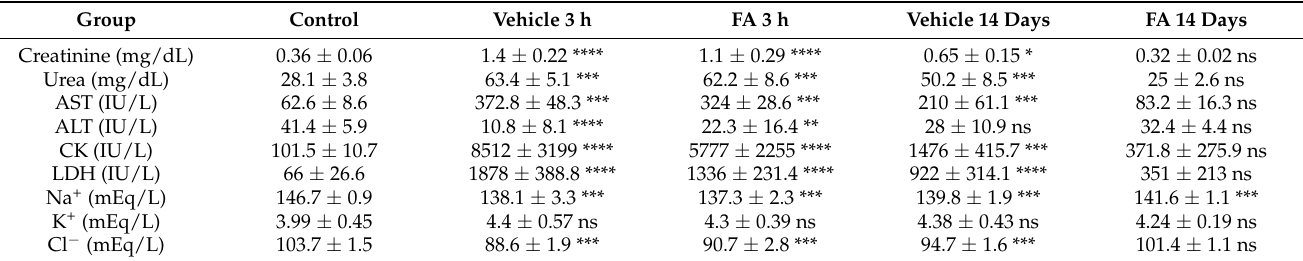
Table 1. Biochemical parameters quantified using the serum samples from the control animals and animals treated with saline (vehicle) or folinic acid (FA) after 3 h or 14 days. Aspartate transaminase (AST), alanine transaminase (ALT), creatine kinase (CK), lactate dehydrogenase